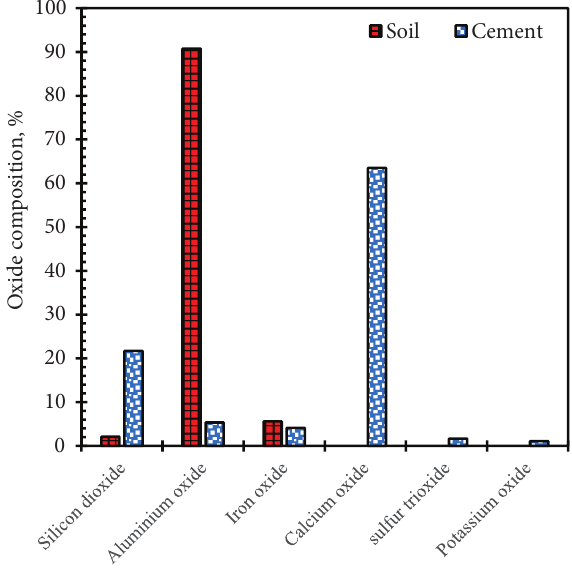
Table 1. Geotechnical properties of the uncontaminated